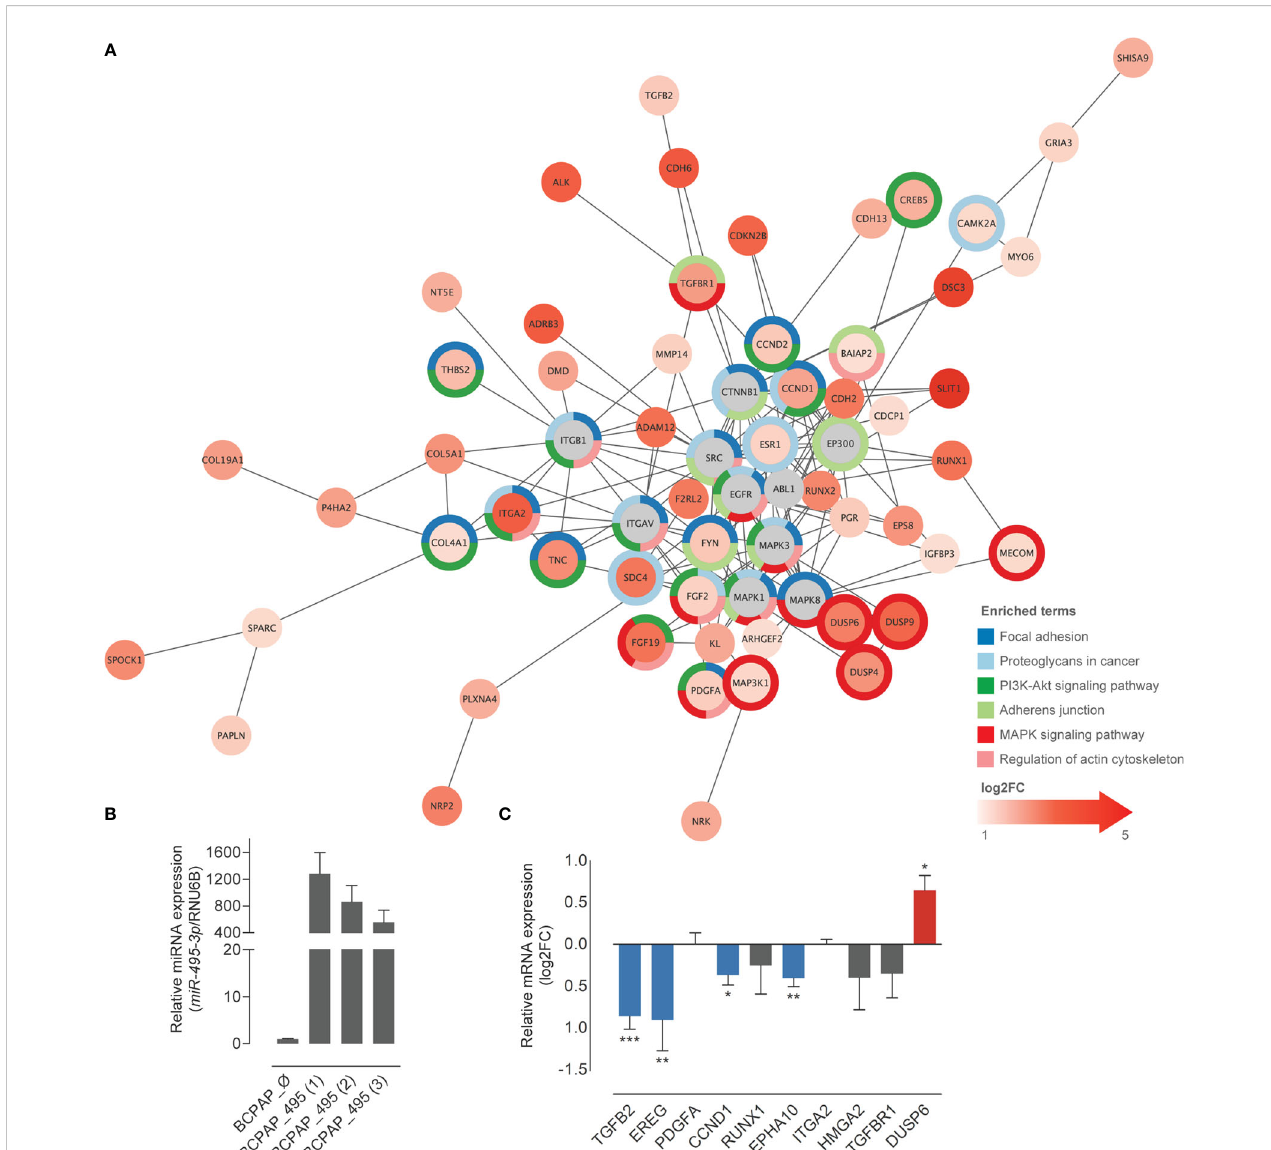
FIGURE 4 Overexpression of miR-495-3p causes a shift in the expression of predicted targets. (A) Predicted targets of miR-495-3p whose expression were found increased in PTC were submitted to a STRING enrichment analysis using Cytoscape. Targets with higher fold changes are shown in more intense red tones. Chart colors (borders) represent different KEGG enrichment categories. (B) Bar plot shows the expression of miR-495-3p among transfected different clones. The one with the highest expression (BCPAP_495 (1)) was used to perform functional validation. (C) Bar plot shows the log2FC of some of miR-495-3p predicted targets in BCPAP cells over expressing the miRNA. Data is presented as the average of at least three independent experiments and bars represent the standard errors of means (SEMs). RPL19 was used as the endogen control. Student ’ s tests were used to compare expression of each gene between groups (*P<0.05, **P<0.01,